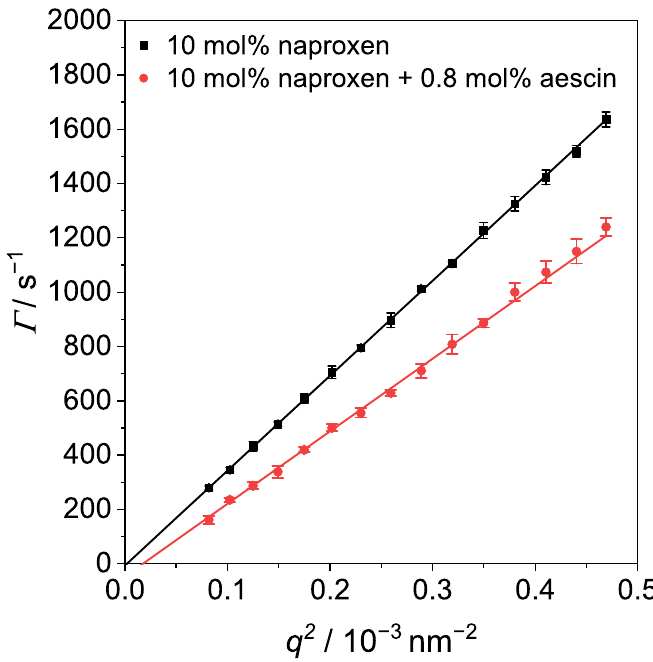
Figure 10. Γ plotted against q 2 measured by angle-dependent PCS at T = 10 °C for DMPC vesicles with 10mol% naproxen and vesicles with 10mol% naproxen and 0.8mol% aescin. Black and red lines are linear fits to determine D T .